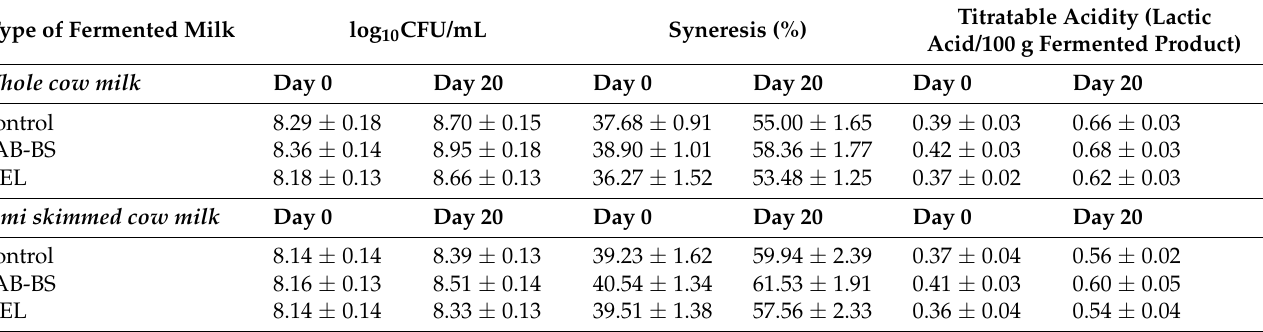
Table 3. Microbiological and physicochemical changes during cold storage of fermented milk pre- pared using the strain L. pentosus FMCC-E108 on whole and semi skimmed milk with and without the addition of lactobacilli and Moesziomyces